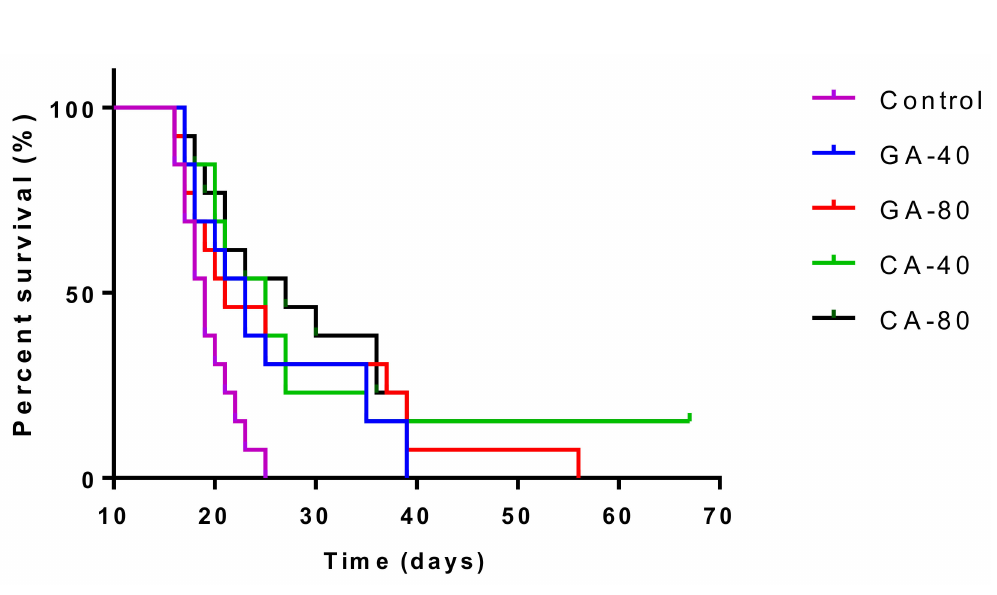
a Mice were injected intraperitoneally ( ip ) with 2.5 × 10 6 viable EAT cells and treated with GA or CA at a dose of 40 mg / kg and 80 mg / kg ip in exponential tumor growth phase on days 5, 7, 9, and 11. The results are expressed as the mean value of each experimental group ± SE of the mean ( n = 11). b T / C% = T / C × 100; T, mean survival days of treated group; C, mean survival days of control group treated with saline. c ILS% (increased life span %) = (T–C) / C × 100. d LTS%, long-term survivors: mice surviving more than 67 days after the ip inoculation of EAT cells.